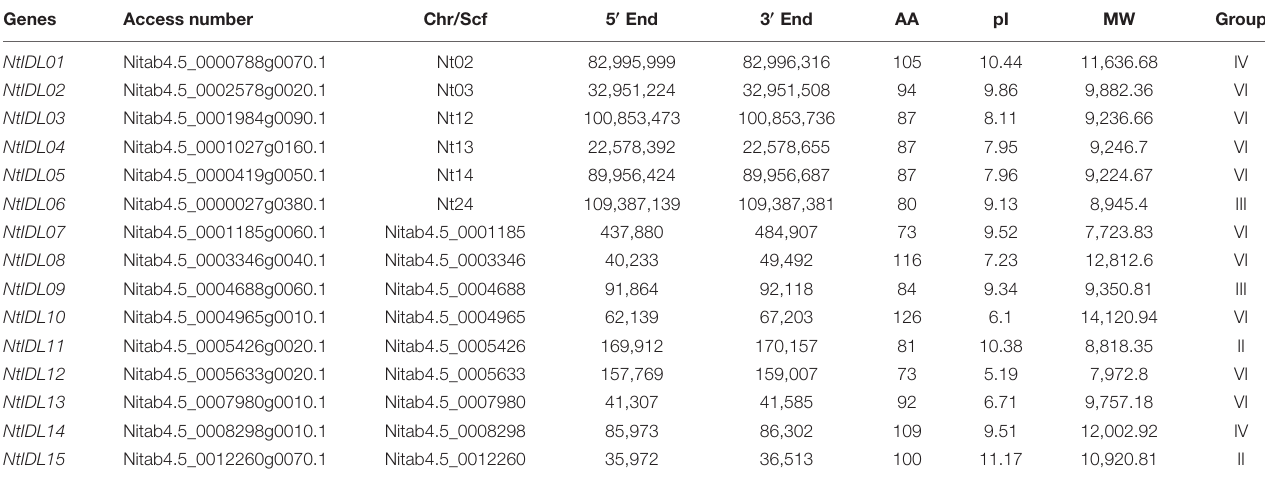
TABLE 1 | IDA-Like gene family members in